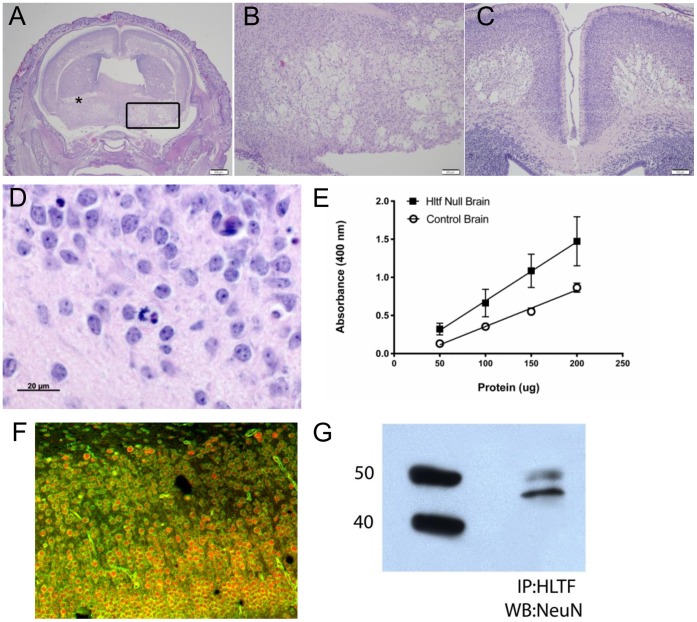
Hltf expression in null and control brains.H&E stained coronal sections from newborn Hltf null mouse brains (A–D); caspase 3 assays comparing null and control brains (E); immunofluorescence image (F) and Western analysis of immunoprecipitates (G) from control brains. Panel A, widespread vacuolation in the anteriorcommissure (*) and preoptic/ventral paladium (boxed region). Panel B, higher magnification of the cholinergic-rich ventral paladium involved in regulation of motivation and behavior. Panel C, extensive bilateral vacuolation in the motor cortex. Panel D, apoptotic cells (pyknotic fragmented nuclei, condensed and hypereosinophilic cytoplasm) in regions of encephalomalacia. Panels E, active caspase-3 shows increased intrinsic triggering of apoptosis in Hltf null brains. Panel F, acquired confocal images were imported into Metamorph 6.3 image analysis software and merged to show NeuN (red) and Hltf (green) colocalize in nuclei (orange) of neurons in the motor cortex. Panel G, NeuN/Fox-3, a member of the Fox-1 gene family of splicing factors, and marker for nuclear speckles, coimmunoprecipitates with Hltf.